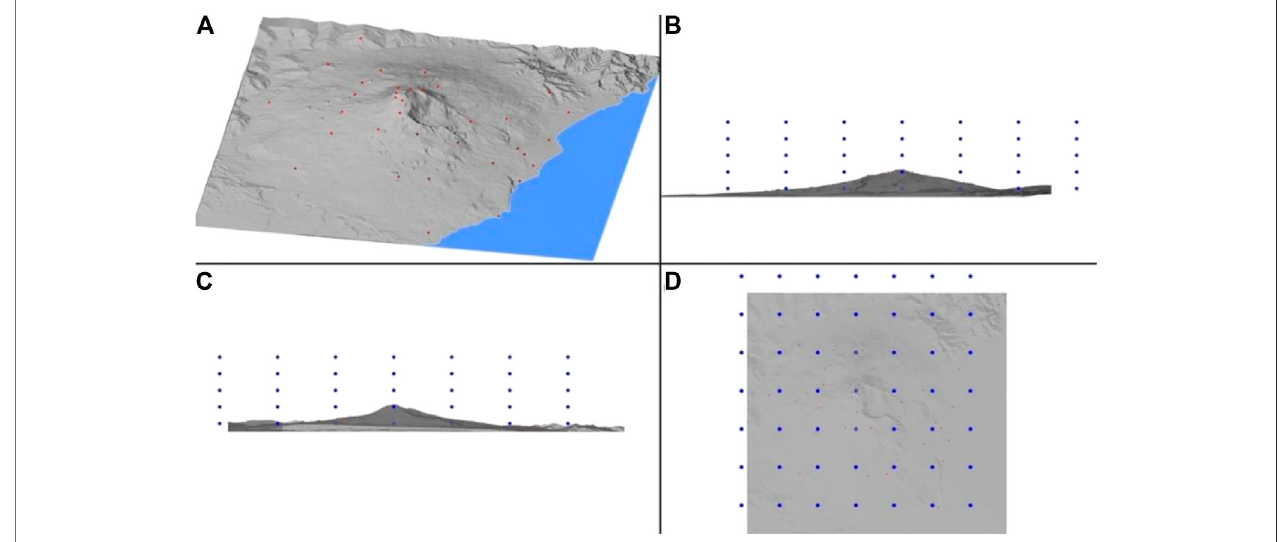
FIGURE5| 3DTomographicmodel3-Dsetup;thevolumesizeof54 × 54 × 10 kmisequallyspacedin7 × 7 × 5voxelscenteredonMt.Etna ’ ssummitcraters: (A) whole volcano (red dots represent GPS stations); (B) layers on the eastern fl ank; (C) layers on the northeastern fl ank; (D) Nadir view. The blue dots represent the voxel centers.